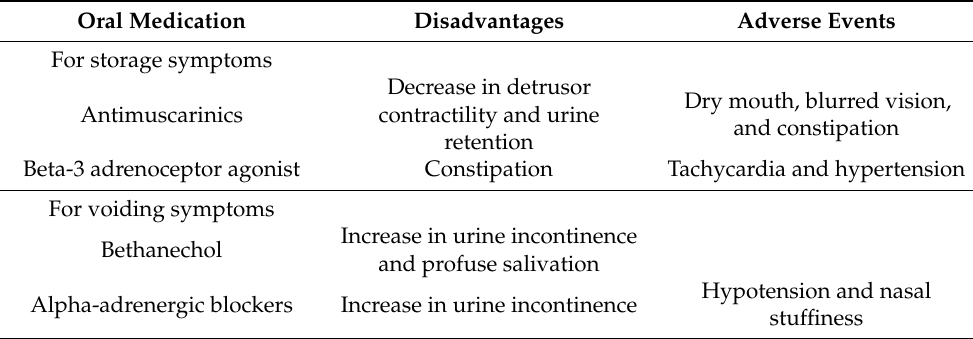
Table 1. Summary of oral medications for neurogenic lower urinary tract dysfunction in chronic SCI